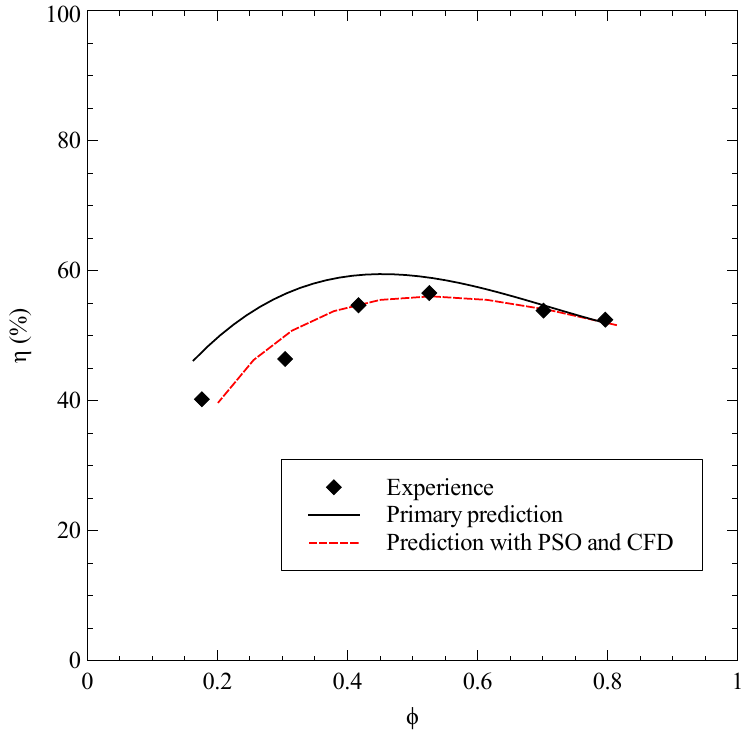
Figure 27. Comparison of efficiency considering fixed vortex and variable vortex size.